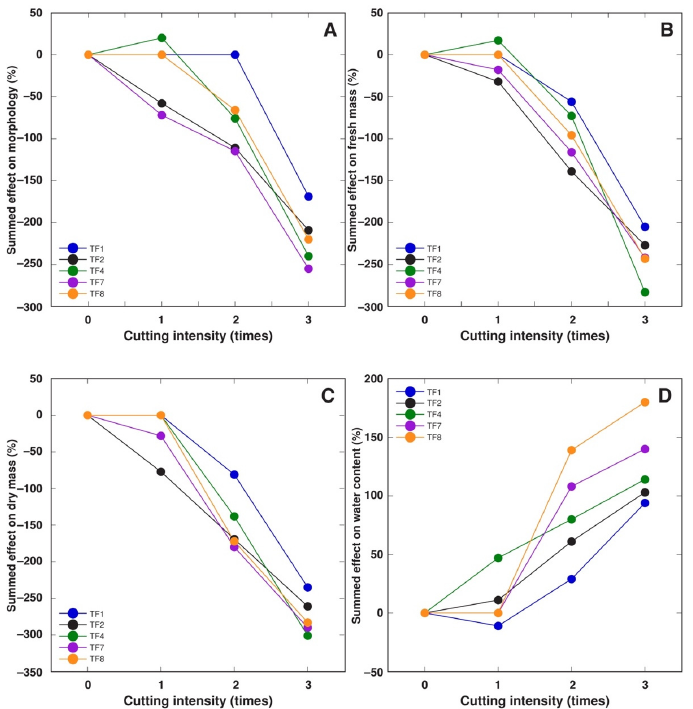
Figure 8. Summed effect of increasing cutting intensity on morphology ( A ), fresh mass of plant parts ( B ), dry mass of plant parts ( C ), and water content in plant parts ( D ) of Trifolium fragiferum plants of different accessions. Measurements were performed after six weeks of treatment plus three weeks of recovery. Only statistically significant effects are taken into the account. Relative comparison of overall tolerance of individual accessions of T. fragiferum to the tested abiotic factors by grading into four categories showed that TF1 was the most tolerant from these accessions, with very high score against both waterlogging and cut- ting, and high score against trampling (Table 4). Only flooding tolerance of TF1 was low. TF2 stood out with very high tolerance to trampling, but also had low tolerance to cutting, with moderate tolerance to increased soil moisture. TF7 had high tolerance to trampling, but scored low or moderate for other factors. The reference cultivar, TF8, appeared to be the most sensitive, with low scores for all factors but cutting. To compare the relative effect of increased moisture treatments on different T. fragiferum accessions, the percentage change from controls for the various parameters by the respective treatment was summed by parameter group, taking into the account only statistically significant changes. This comparison allowed us to notice that morphological parameters (number of stolons, number of leaves, average and total length of stolons) were the least affected by increased moisture (Figure 4A). In this respect, flooding was more unfavorable than waterlogging for TF1, TF2, and TF8, but the opposite effect was